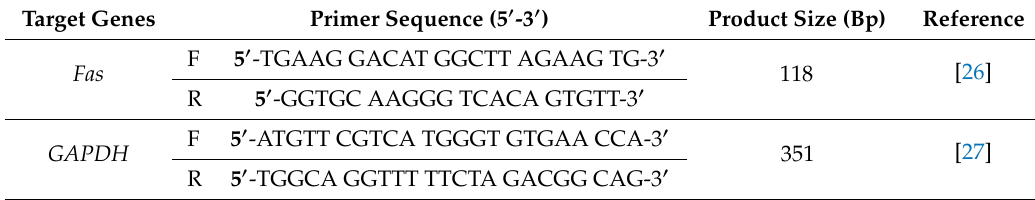
Table 2. Oligonucleotide sequences of the semi-quantitative RT-PCR